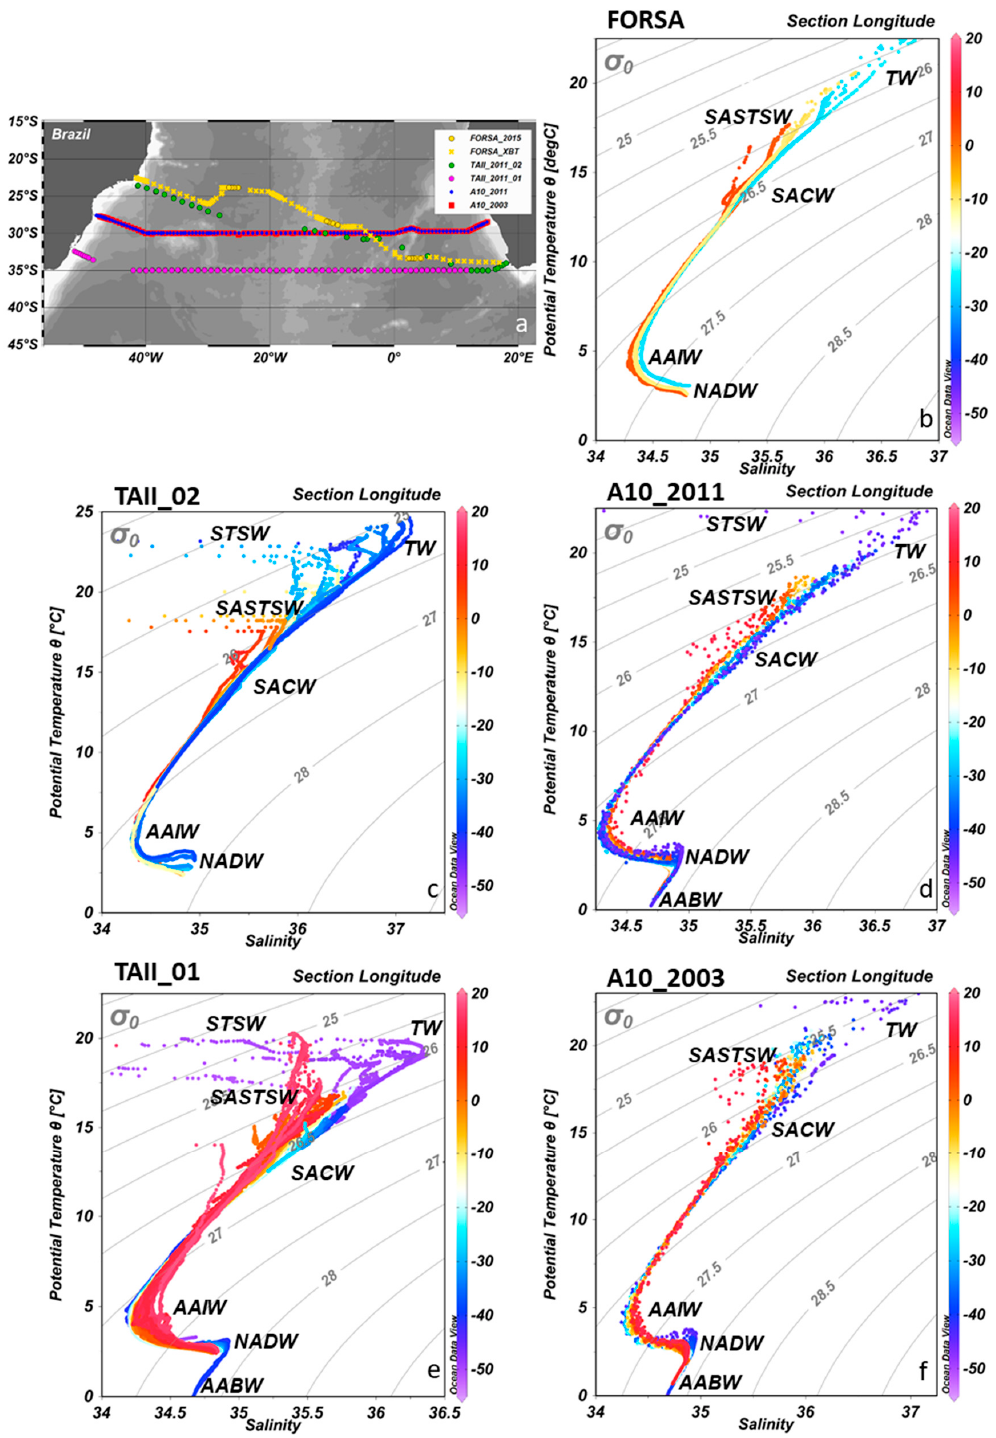
Figure 3. Map of the cruise sections ( a ). For a complete description of this map, please see Figure 1. θ /S-longitude diagrams for each section ( b – f ). θ /S-longitude of the FORSA–2015 cruise section ( b ), TAII_02–2011 section ( c ), A10_2011 section ( d ), TAII_01–2011 section ( e ), and A10_2003 section ( f ). The continuous gray lines represent the isopycnals. The water masses are indicated by their acronyms, referring to: Subtropical Shelf Water (STSW), Tropical Water (TW), South Atlantic Subtropical Surface Water (SASTSW), South Atlantic Central Water (SACW), Antarctic Intermediate Water (AAIW), North Atlantic Deep Water (NADW), and Antarctic Bottom Water (AABW). For details please see the water masses properties (Table 3).